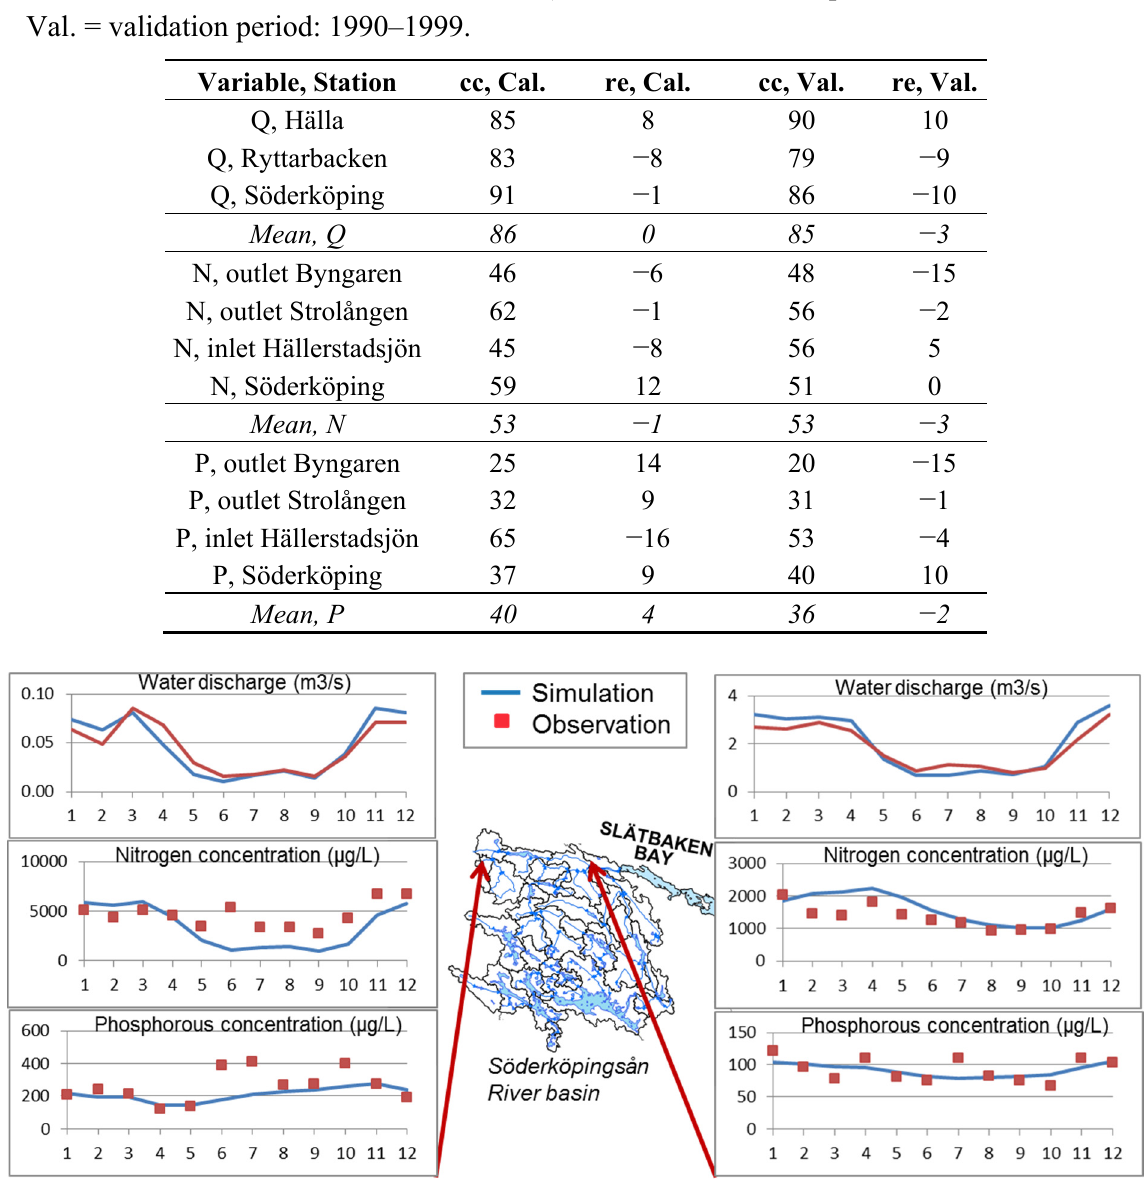
Figure 4. Daily averages of HYPE simulations vs. monthly averages of observations for water discharge, total N and P concentrations for Ryttarbacken, a small subcatchment dominated by arable land, and in Storån River, close to the outlet (1–12 in x -axis indicates the months January to